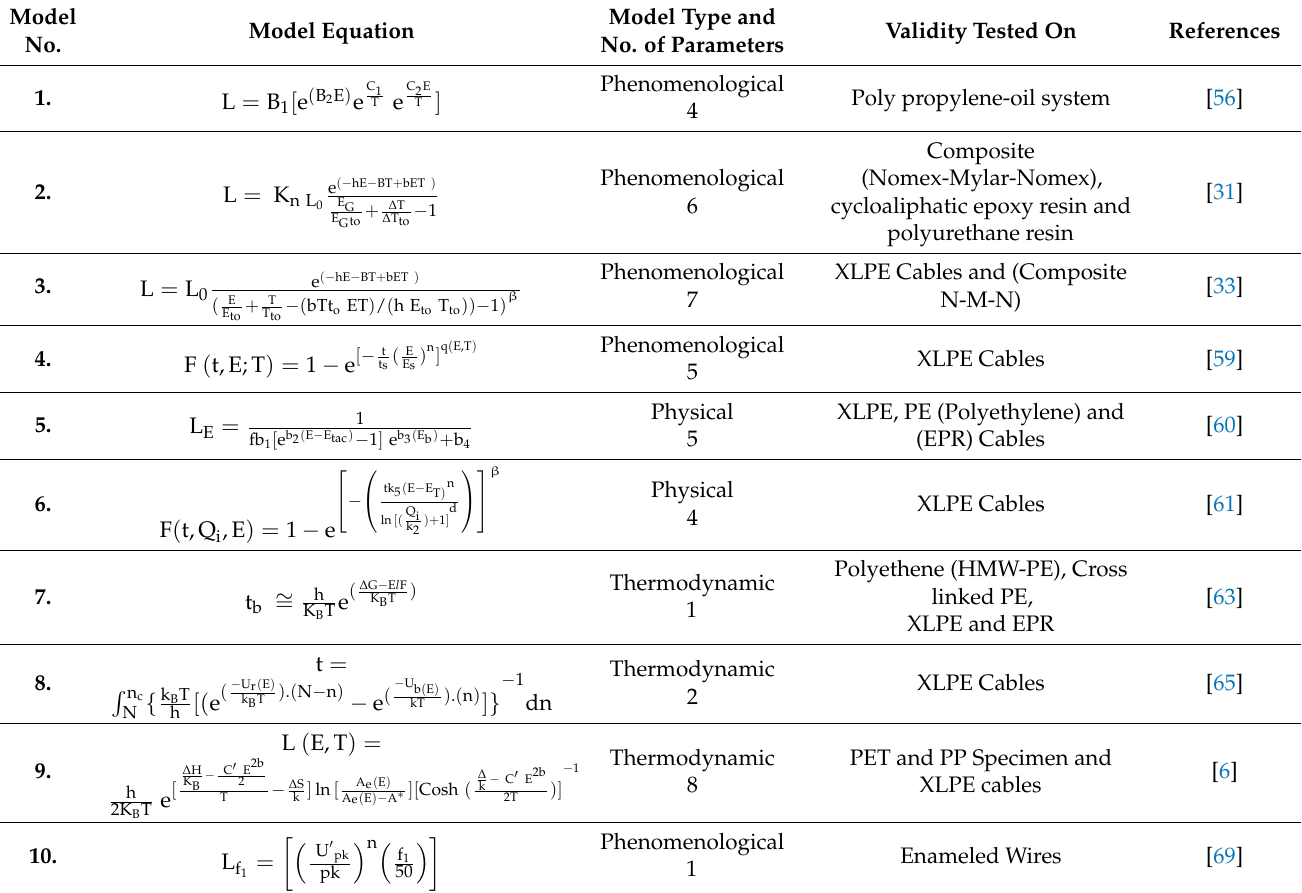
Table 1. Summary of reviewed multistress aging